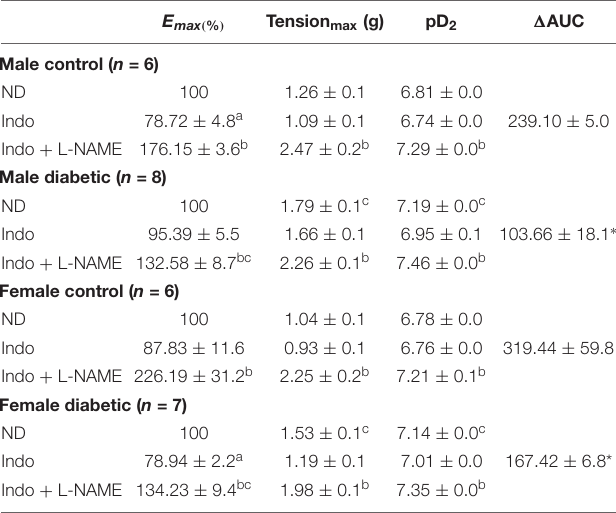
TABLE 5 | E max , Tension max , pD 2 , and (cid:49) AUC to phenylephrine (PE) in aortic rings from male and female control and diabetic rats. E max ( % ) Tension max